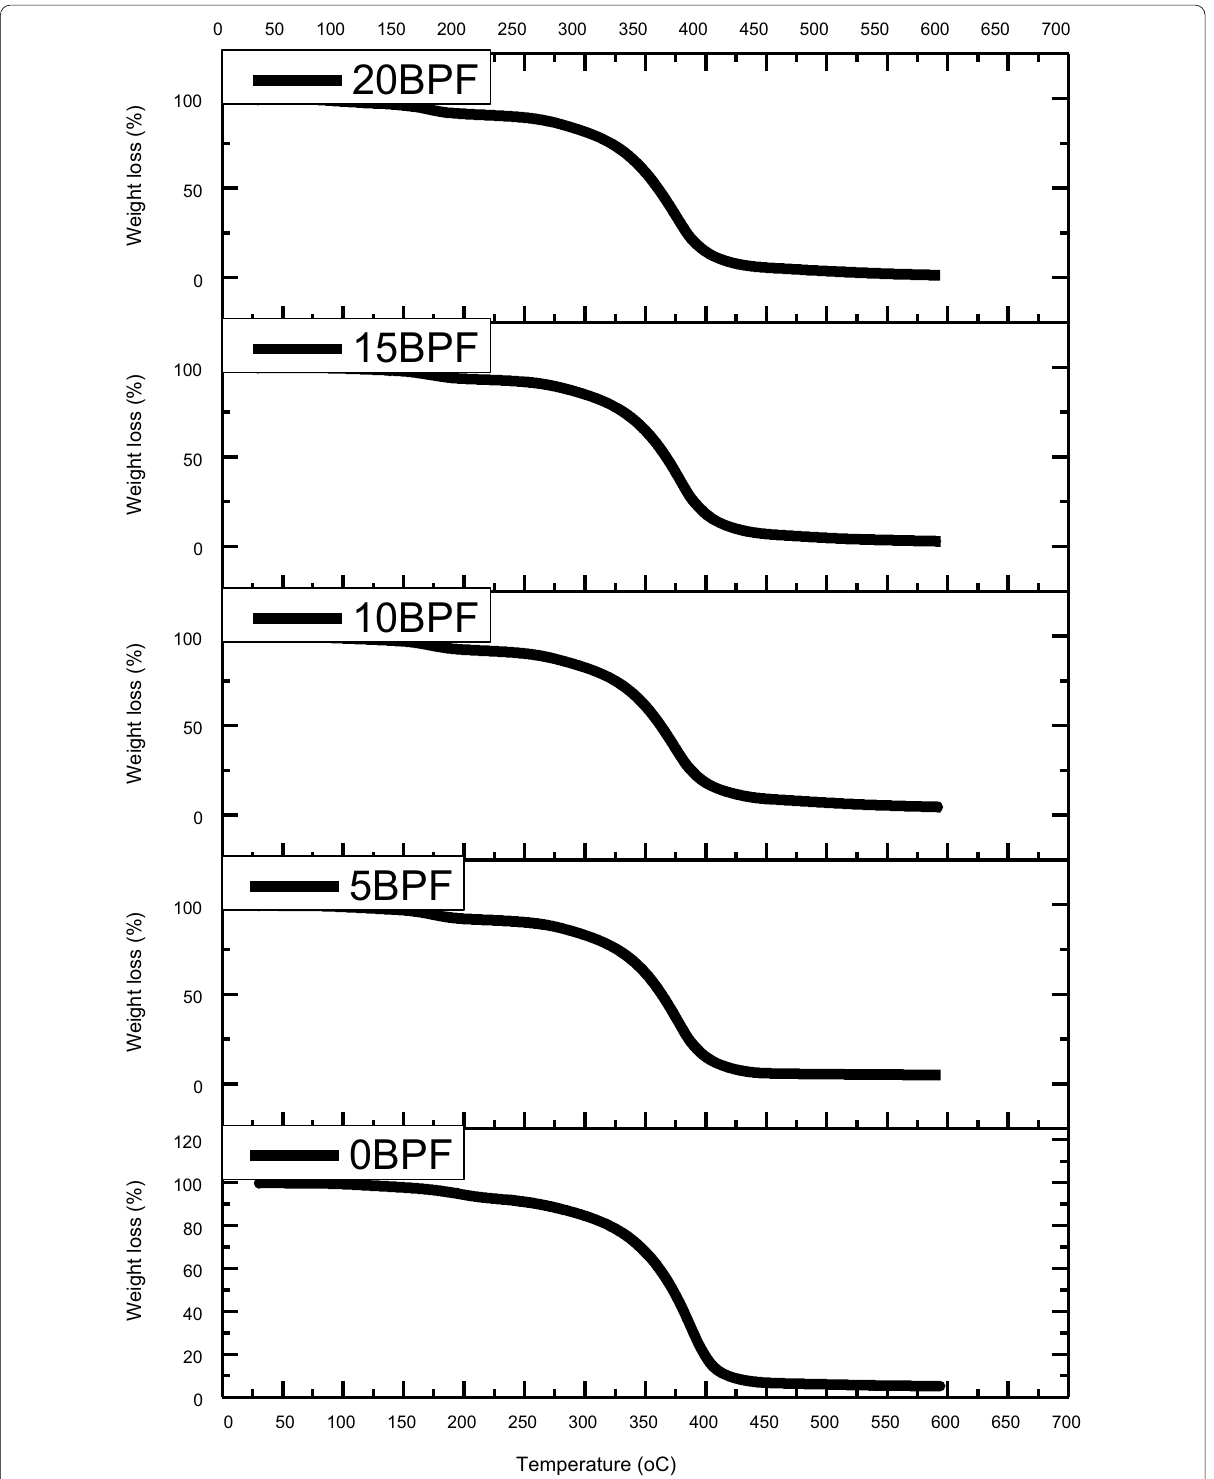
Fig. 8 Variation of percentage weight loss with temperature for composites Produced with